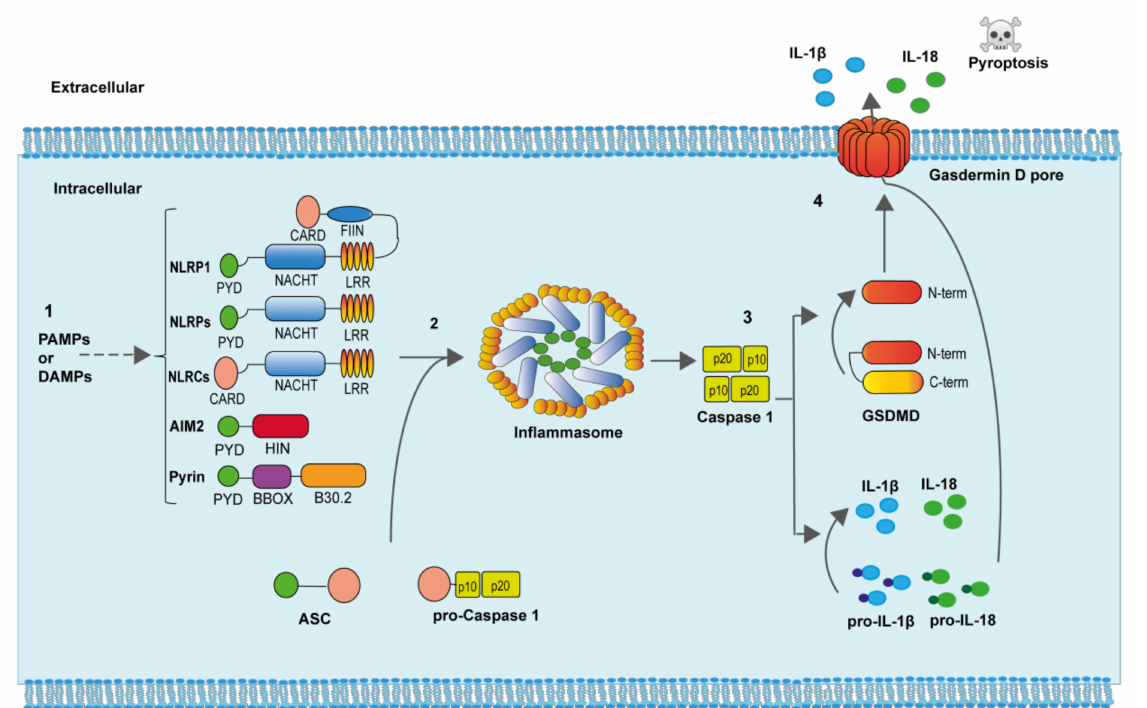
Figure 2. Inflammasome activation. ( 1 ) Specific PAMPs and DAMPs are able to induce both the expression and oligomeriza- tion of the different inflammasome sensor proteins. ( 2 ) The adaptor ASC protein oligomerizes within the inflammasome and recruits pro-caspase-1, favoring caspase-1 autoactivation. ( 3 ) Active caspase-1 cleaves the precursors of the pro-inflammatory cytokines IL-1 β and IL-18, as well as the protein GSDMD. The N-terminal portion of GSDMD binds and produce pores in the plasma membrane. ( 4 ) The active pro-inflammatory cytokines IL-1 β and IL-18, as well as diverse intracellular content, is released through GSDMD pores. Increasing formation of GSDMD pores produces cell swelling and pyroptotic cell